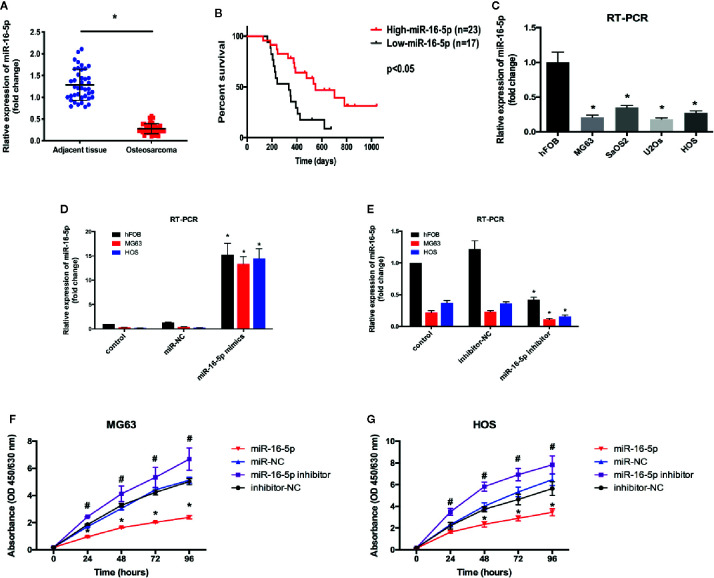
The expression level of miR-16-5p in osteosarcoma and normal cells. (A, C) miR-16-5ps in human osteosarcoma and adjacent tissue samples and cell lines were detected by real-time PCR (RT-PCR). (B) Kaplan-Meier survival rates for overall survival (OS) patients with high (n=23) and low (n=17) miR-16-5p expression. (D, E) miR-16-5p in cells transfected with mimics, inhibitor, and negative control were detected by RT-PCR. (F, G) the cell proliferation was evaluated by CCK-8. *indicates p < 0.05.